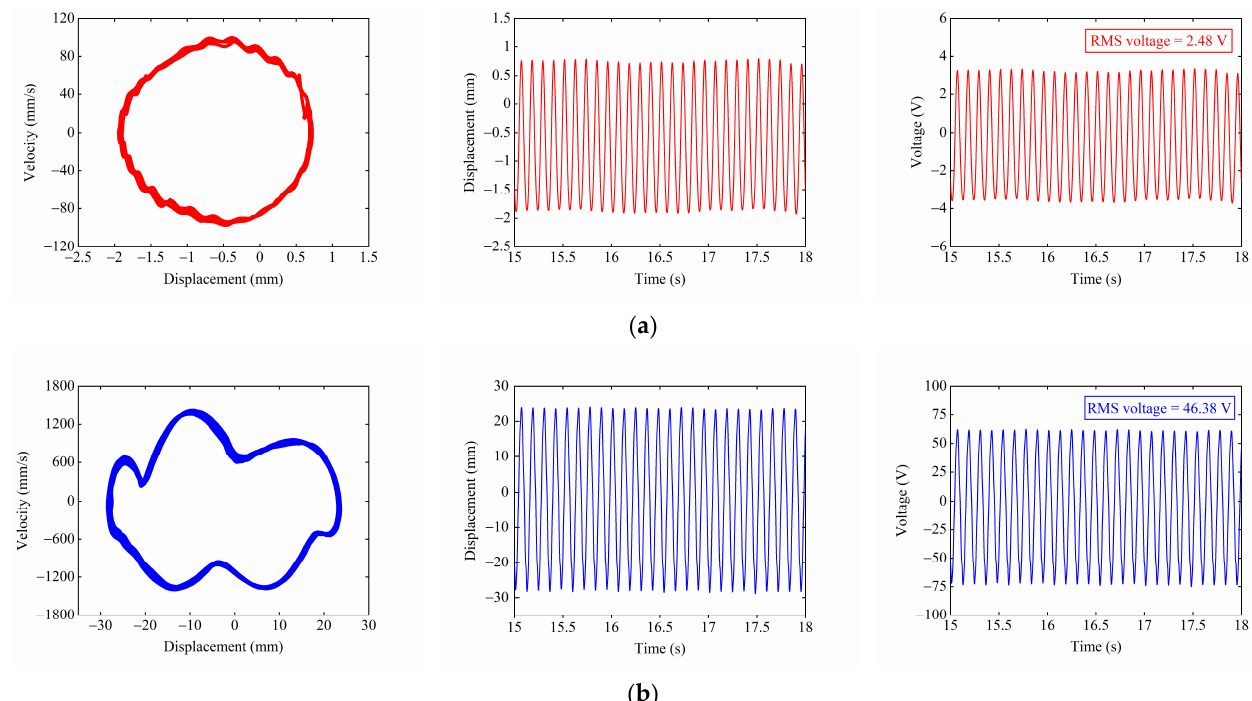
Figure 14. Phase graph, time course graph of the experiment under different M e : ( a ) M e = 4 g; ( b ) M e = 8